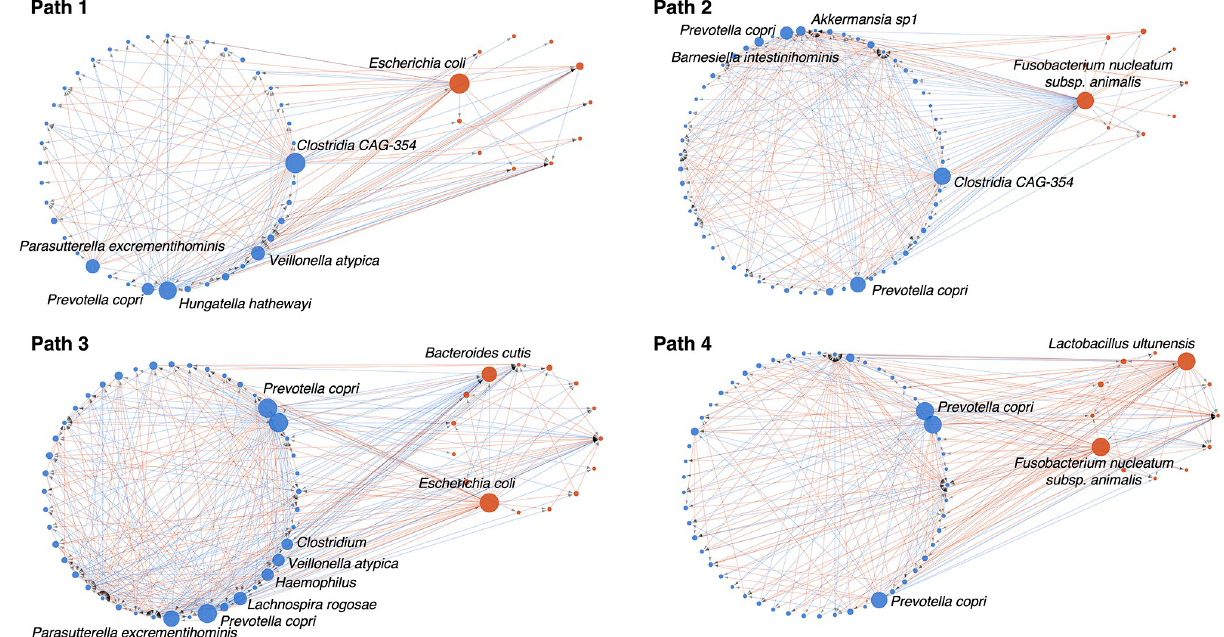
Fig 5. Microbial interaction networks inferred by the gLV method applied to pseudo-time series data recovered from four identified CD progression paths. Each node represents an OTU, its size is proportional to the number of edges directed out of the node (i.e., out-degree), and its face color represents the sign of the correlation of the relative abundance of the OTU with a progression path (red: positive, blue: negative). Only the nodes with out-degrees larger than 10 were annotated. Since compositionality was not considered in the analysis, artificial links might arise. See S9 Fig for detailed